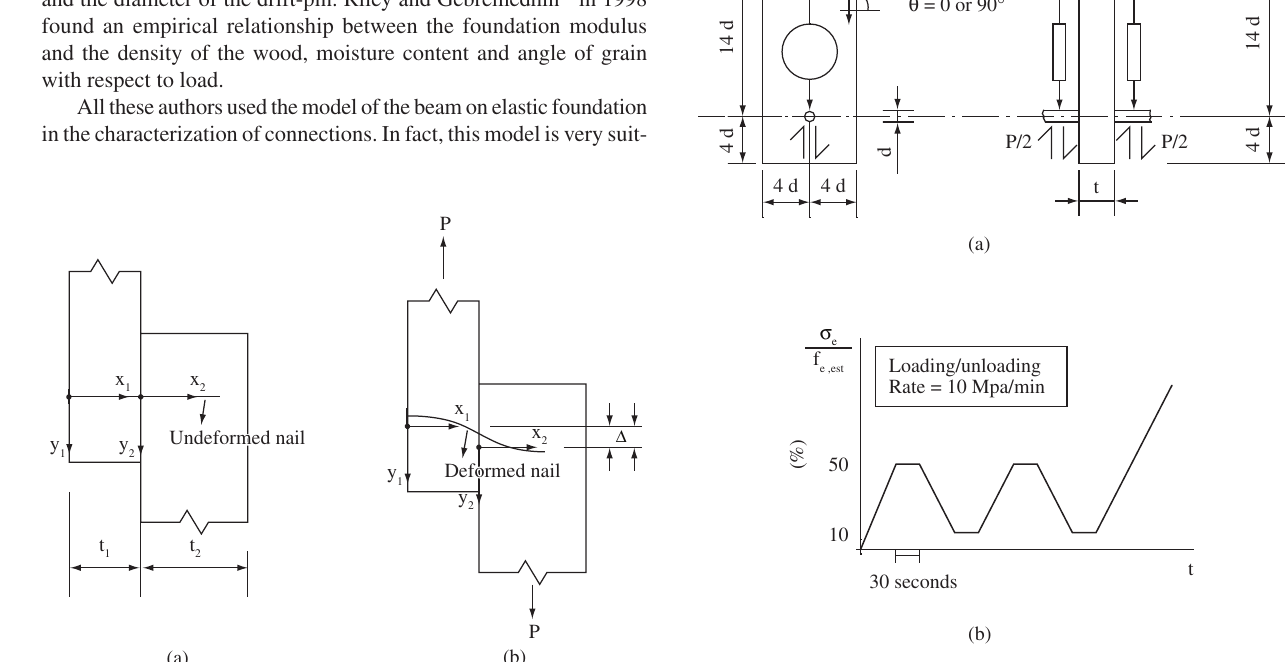
Figure 3. Brazilian Code standard embedding test scheme. a) Teste setup scheme; and b) Loading